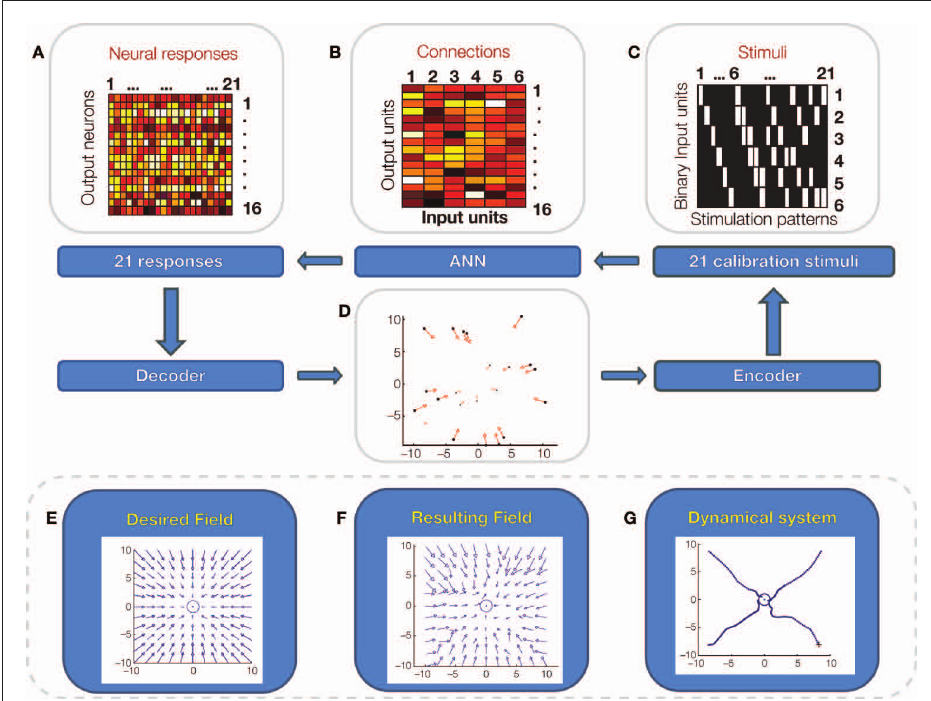
field (E) , acting on a mass-damping system. To perform the calibration, the two top principal components of the 21 neural responses are mapped over the ranges of the force vector components in the desired field. This mapping is performed by the linear decoder. Then, for each force vector, the corresponding point of application is determined and is associated to the stimulus pattern that generated the force vector (D) . A simple form of the stimulus encoder maps the current location of the mass-damping system into the nearest point determined in the calibration. The resulting field generated by the encoder/decoder system (F) is a fragmented approximation of the desired field. (G) : Simulated trajectories of the spring-damper system under the field generated by the